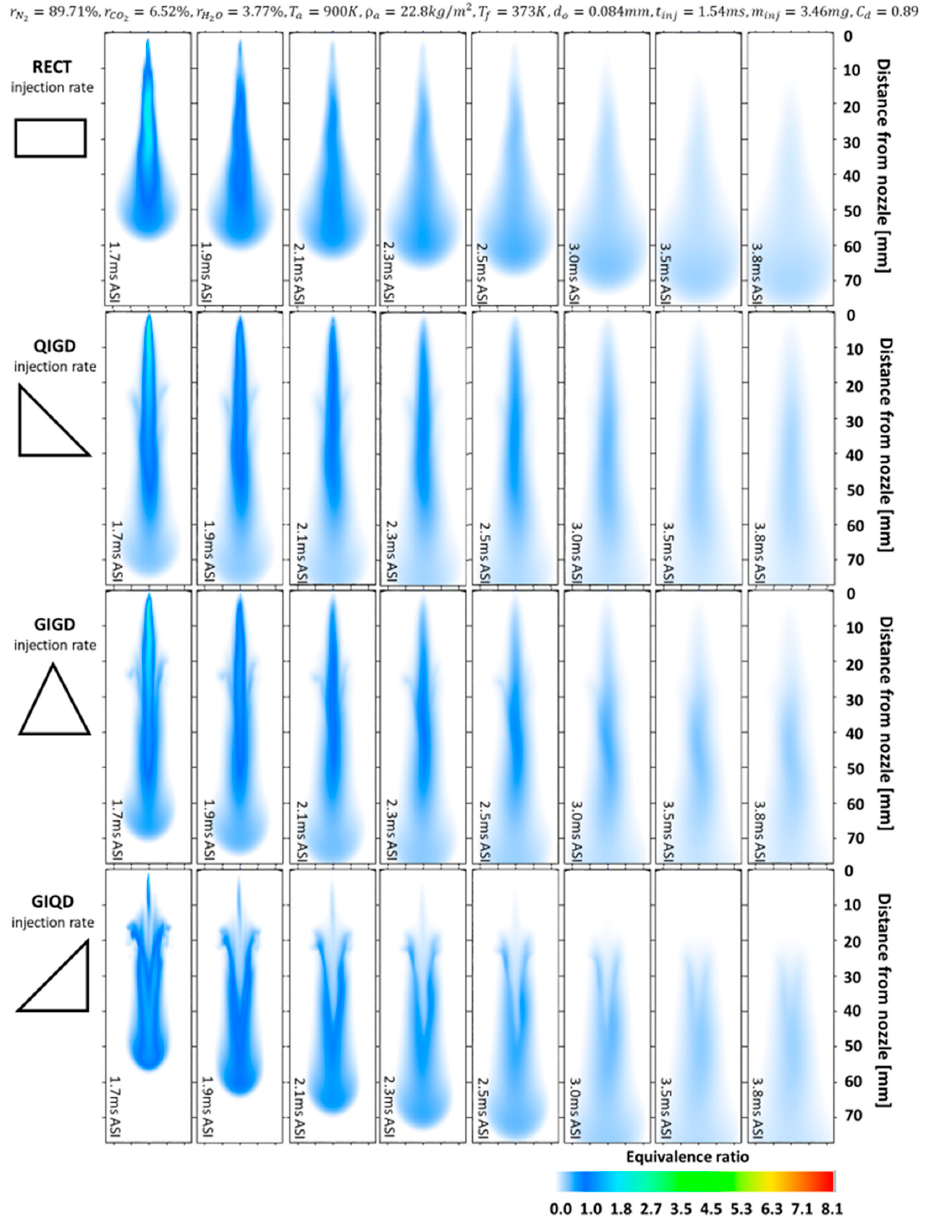
Figure 21. Comparison of the spray behavior and equivalence ratio histories after the EOI for different injection rate shapes.